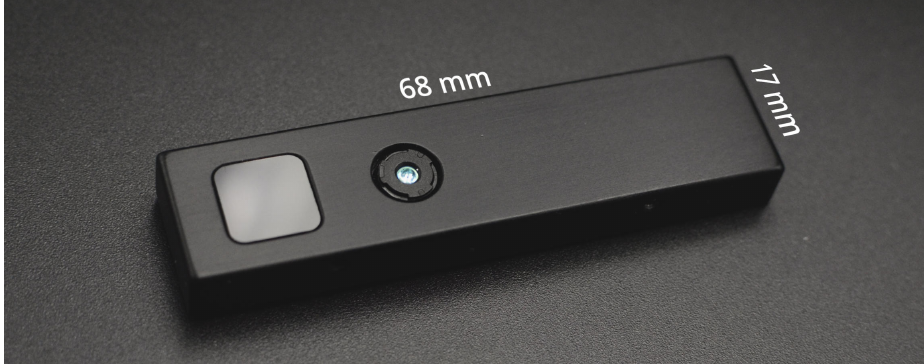
Figure A1. The chosen ToF camera development kit Pico Flexx from